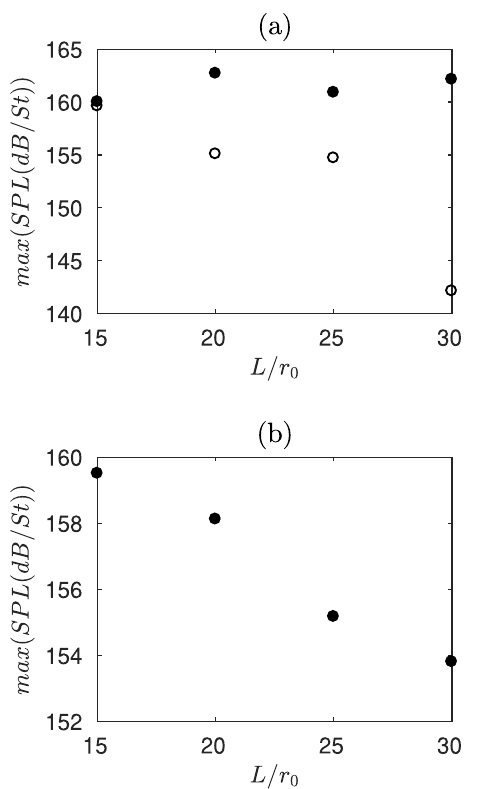
Figure 10. Levels of the peaks in the near-nozzle pressure spectra as a function of the nozzle-to-plate distance for (a) n h = 0 and (b) n h = 1; (cid:7) dominant and (cid:8) secondary